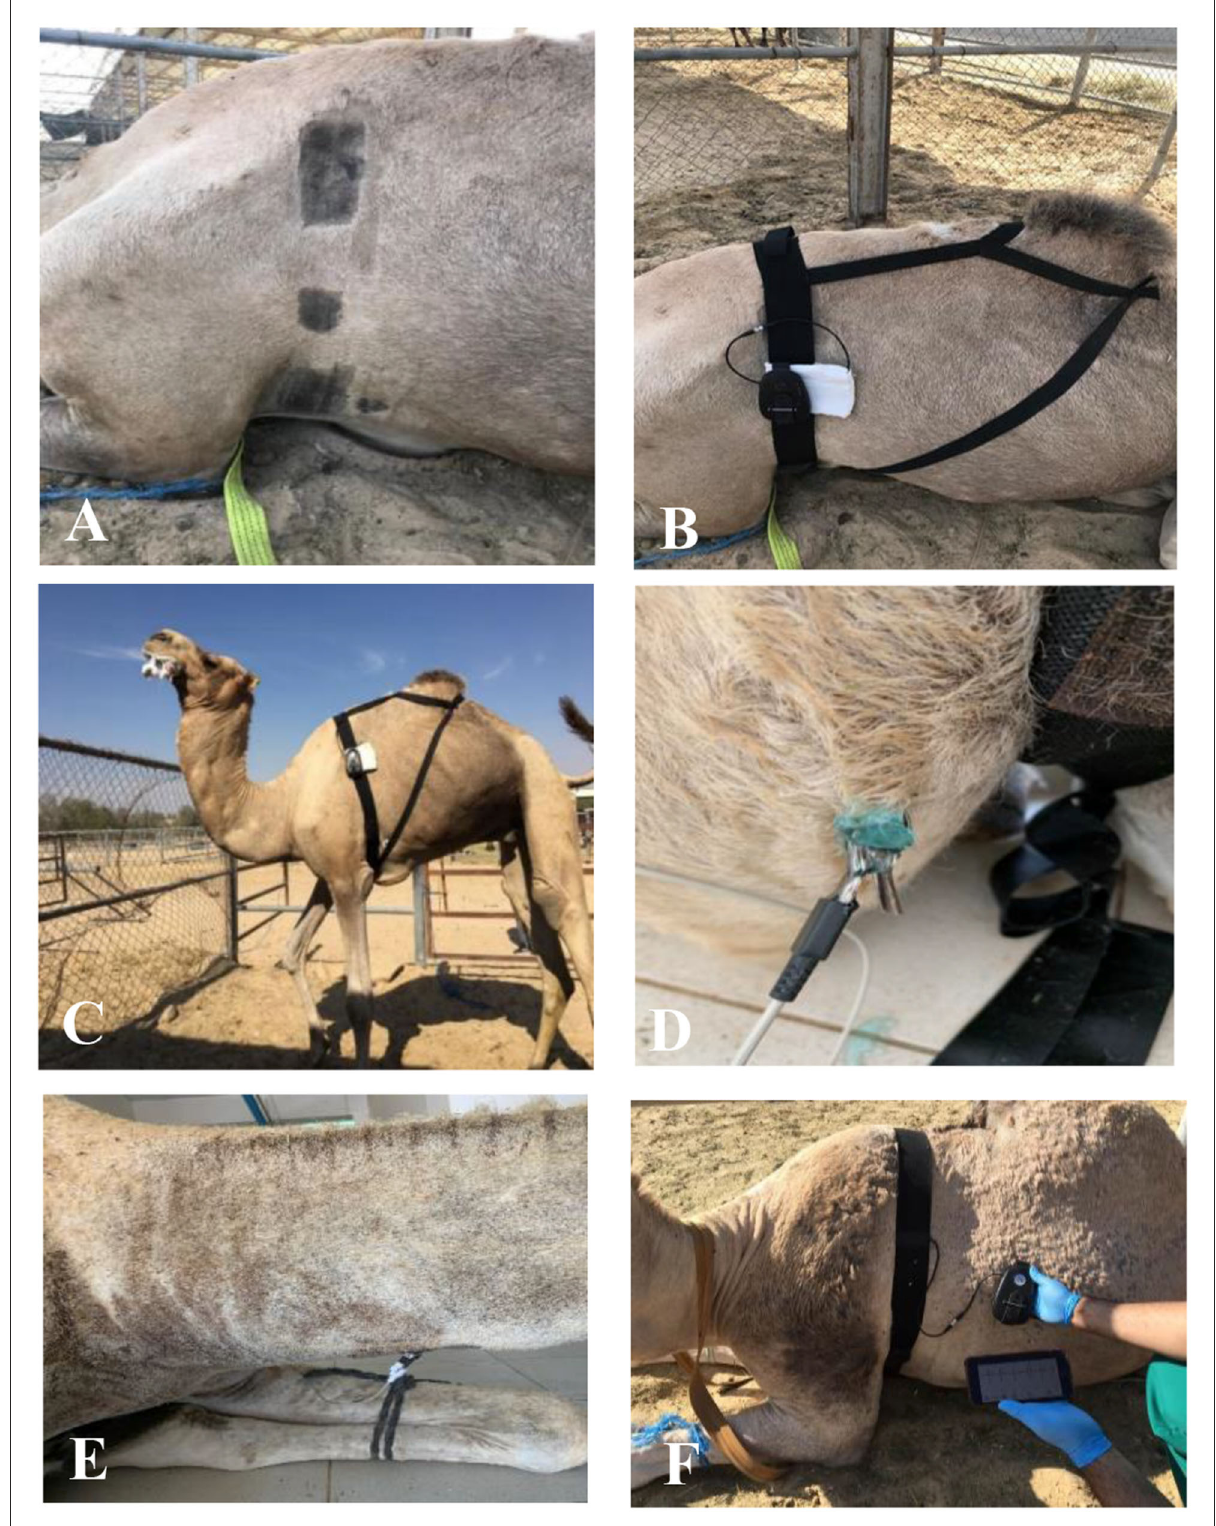
FIGURE1 Positioning electrodes of both devices on camels (A) Shaving area of electrodes (B) Fixing Equimetre Vet (C) Girth after modification (D) Negative standard base-apex electrode (E) Positive standard base-apex electrode (F) Display of live ECG from Equimetre TM